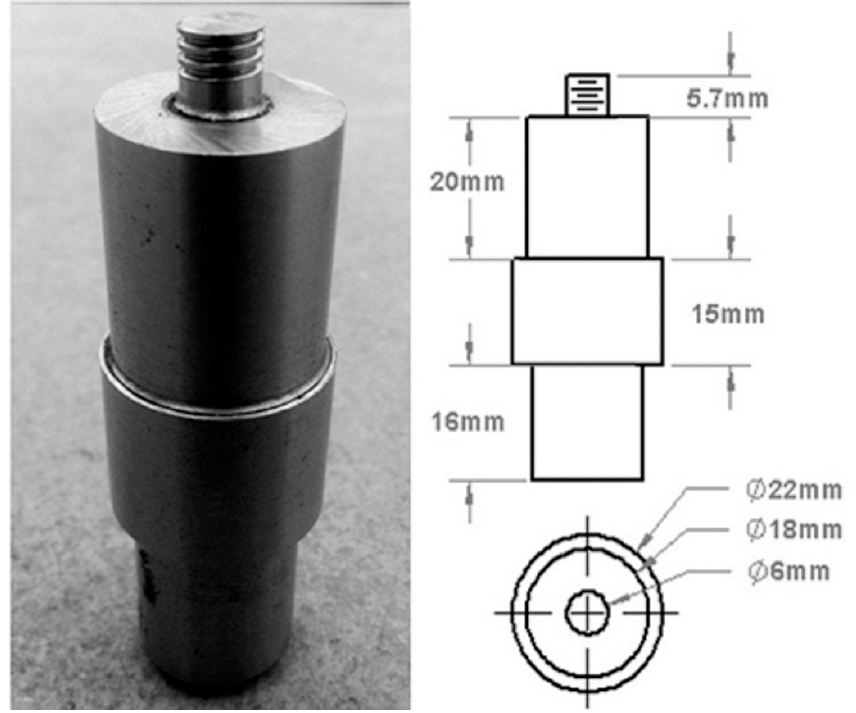
Figure 4. Pictorial representation of the H13 cylindrical threaded tool pin profile.